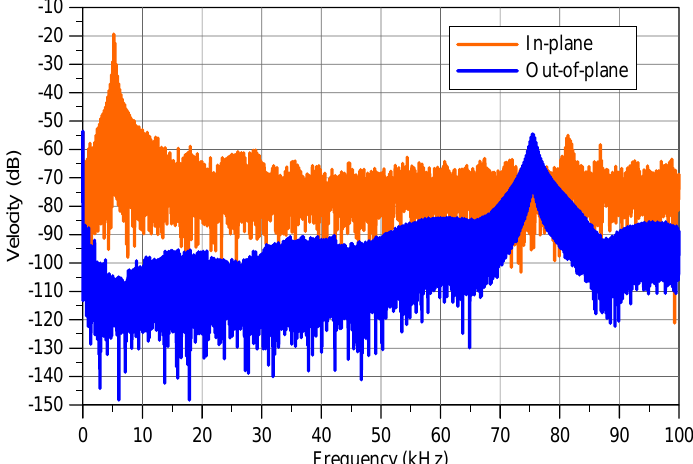
Figure 5. Actuator mode shapes.